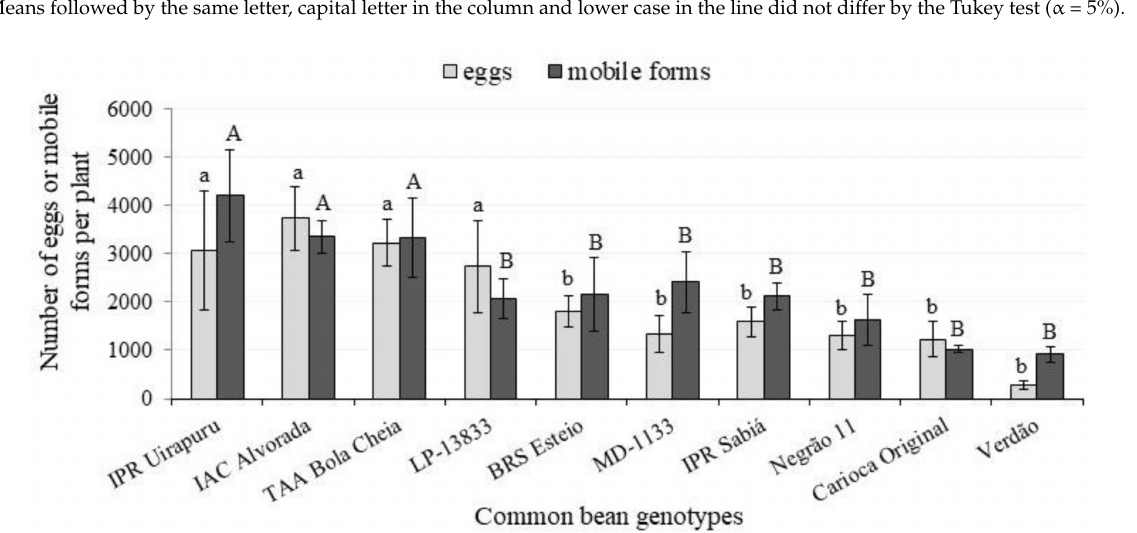
Genotypes Mobile Forms (Larvae and Adults) BRS Esteio